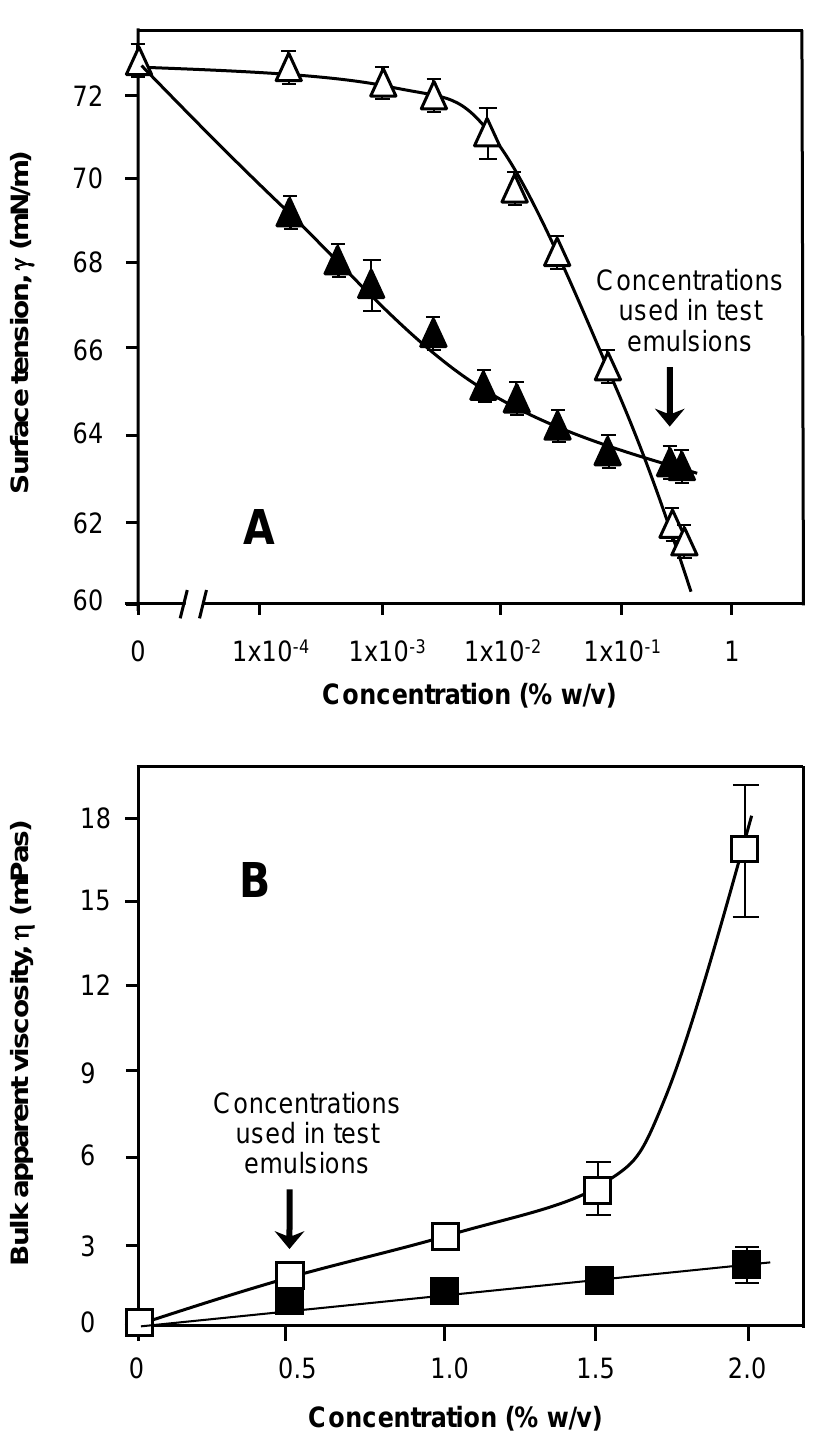
Figure 6. Multiple plot for the test system, indicating surface tension ( A ) and bulk solution viscosity ( B ), estimates for carbopol solutions at 20 ◦ C as a function of increasing bulk concentration, given as a percentage weight-in-volume (% w / v ) in the presence of 1 × 10 − 5 M sodium azide (where error bars are not easily discriminated they are of a smaller magnitude than the dimensions of the symbols; lines represent an aid to the eye to show the trend in the data). The polymer samples were carbopol 971P ( (cid:52) ) and carbopol 974P ( (cid:78) ) in tensiometric studies and carbopol 971P ( (cid:3) ) and carbopol 974P ( (cid:4) ) in rheological studies All solutions used for samples were prepared from surface chemically pure 50 mM sodium phosphate buffered water, pH